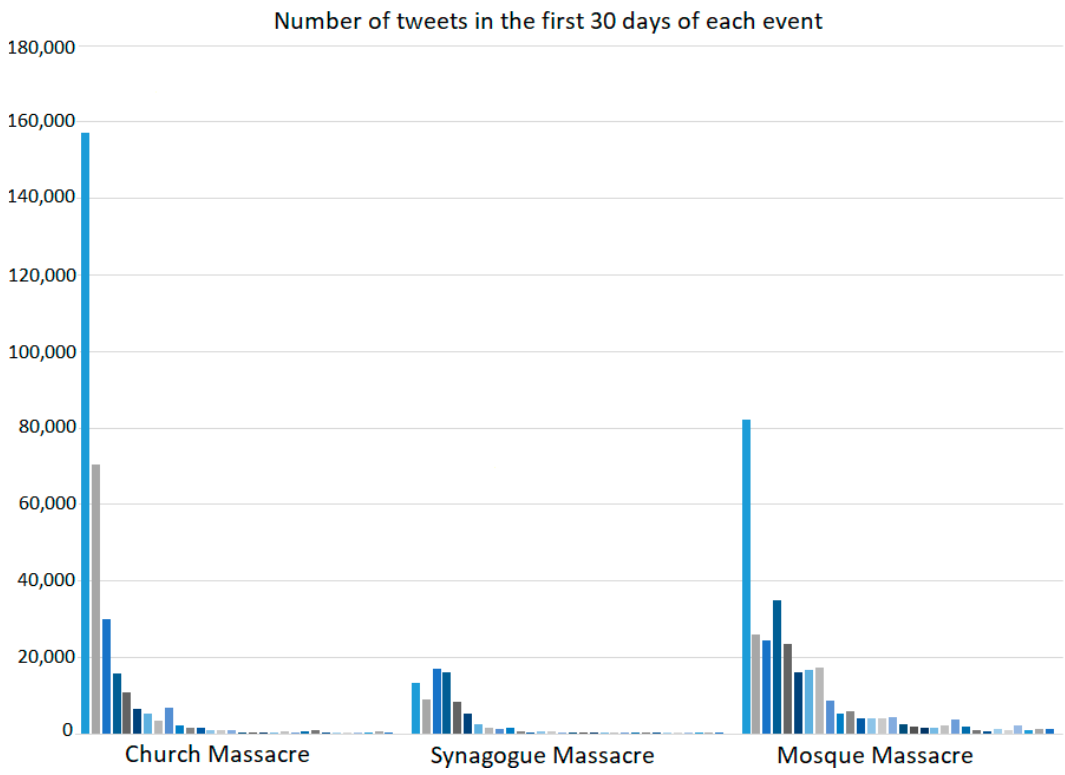
Figure 3. Number of tweets in the first 30 days.